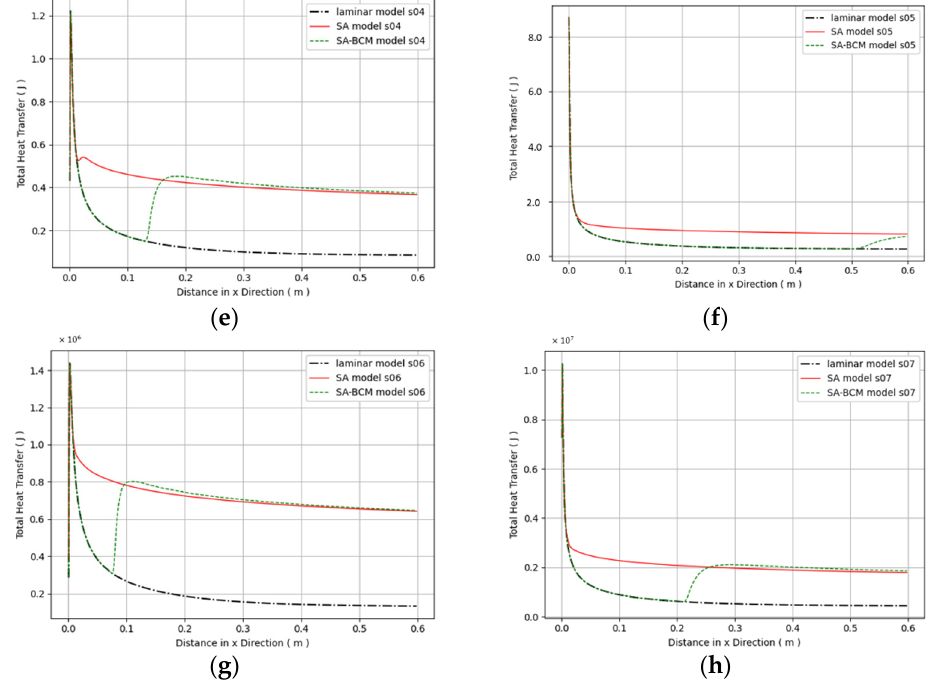
Figure 8. Flow model comparison: ( a ) s00 case; ( b ) s01 case; ( c ) s02 case; ( d ) s03 case; ( e ) s04 case; ( f ) s05 case; ( g ) s06 case; ( h ) s07 case.